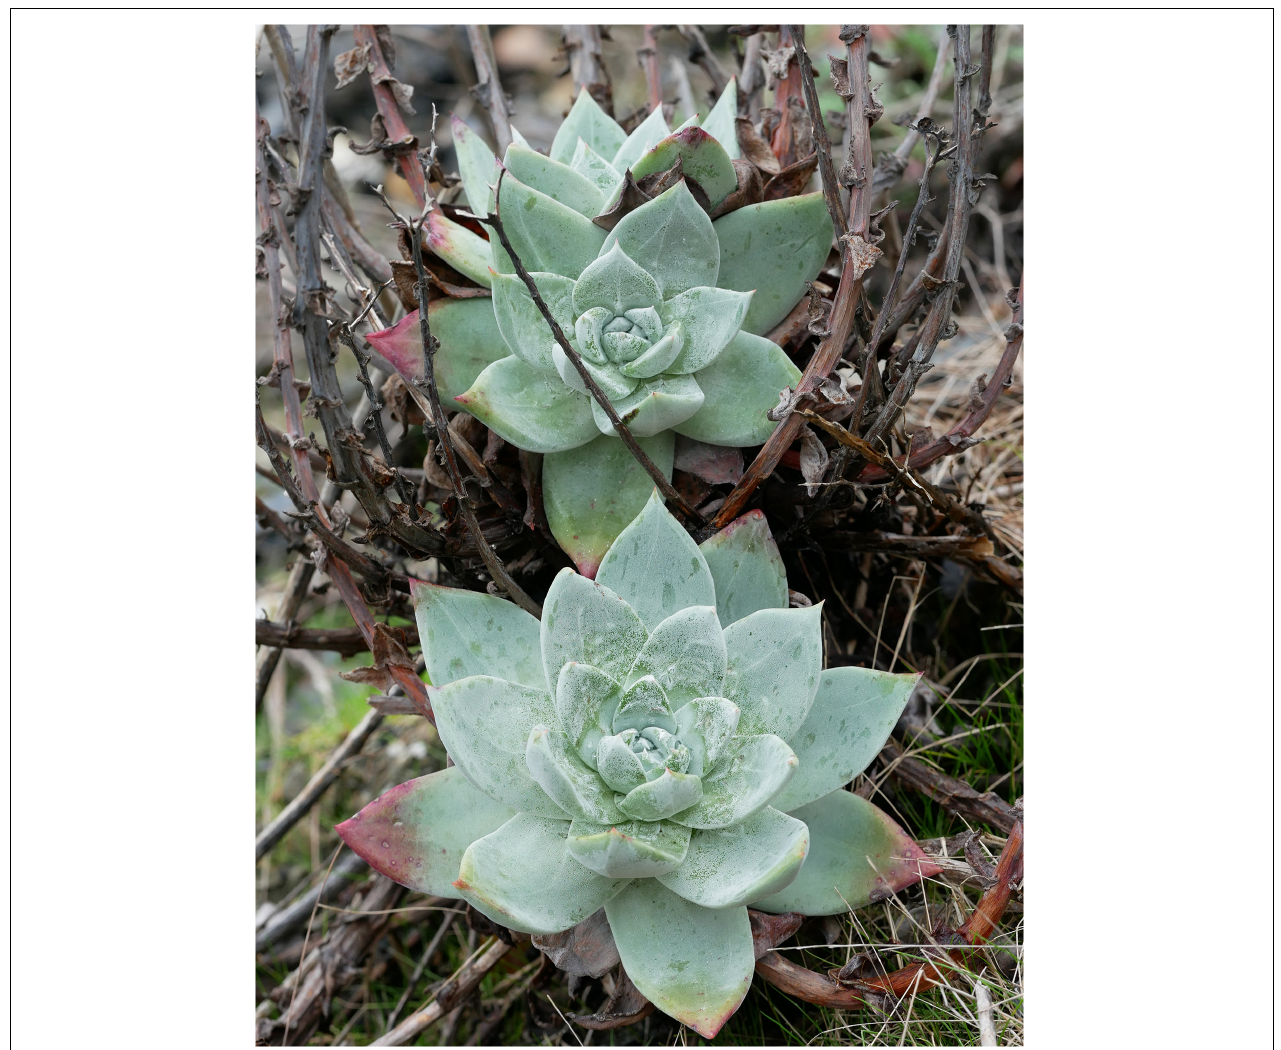
FIGURE 1 | Dudleya farinosa, near Eureka, CA, United States. Photograph by the